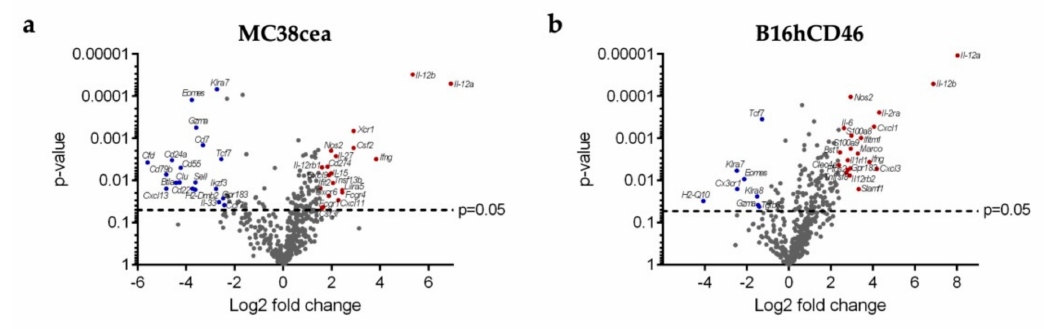
Figure 7. Immune expression profiling. RNA was extracted from n = 4 tumors from each treatment group and expression profiling was carried out using the NanoString Mouse Immunology Panel. Volcano plots show di ff erential gene expression between the FmIL-15 and FmIL-12 treatment groups in the ( a ) MC38cea and ( b ) B16hCD46 tumor models. Each dot represents one gene. The top 20 significantly upregulated genes in the FmIL-12 versus the FmIL-15 group (Log2 Fold change > 1 and p -value < 0.05) are shown in red. The top 20 significantly downregulated genes in the FmIL-12 versus the FmIL-15 group (Log2 Fold change < − 1 and p -value < 0.05), i.e., upregulated in the MeVac FmIL-15 group, are shown in